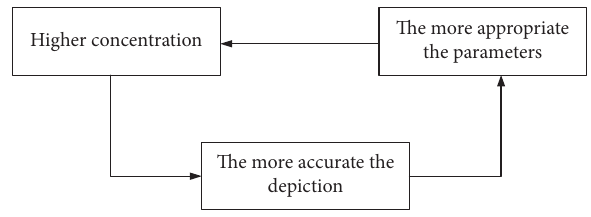
Figure 2: Time-frequency approximation